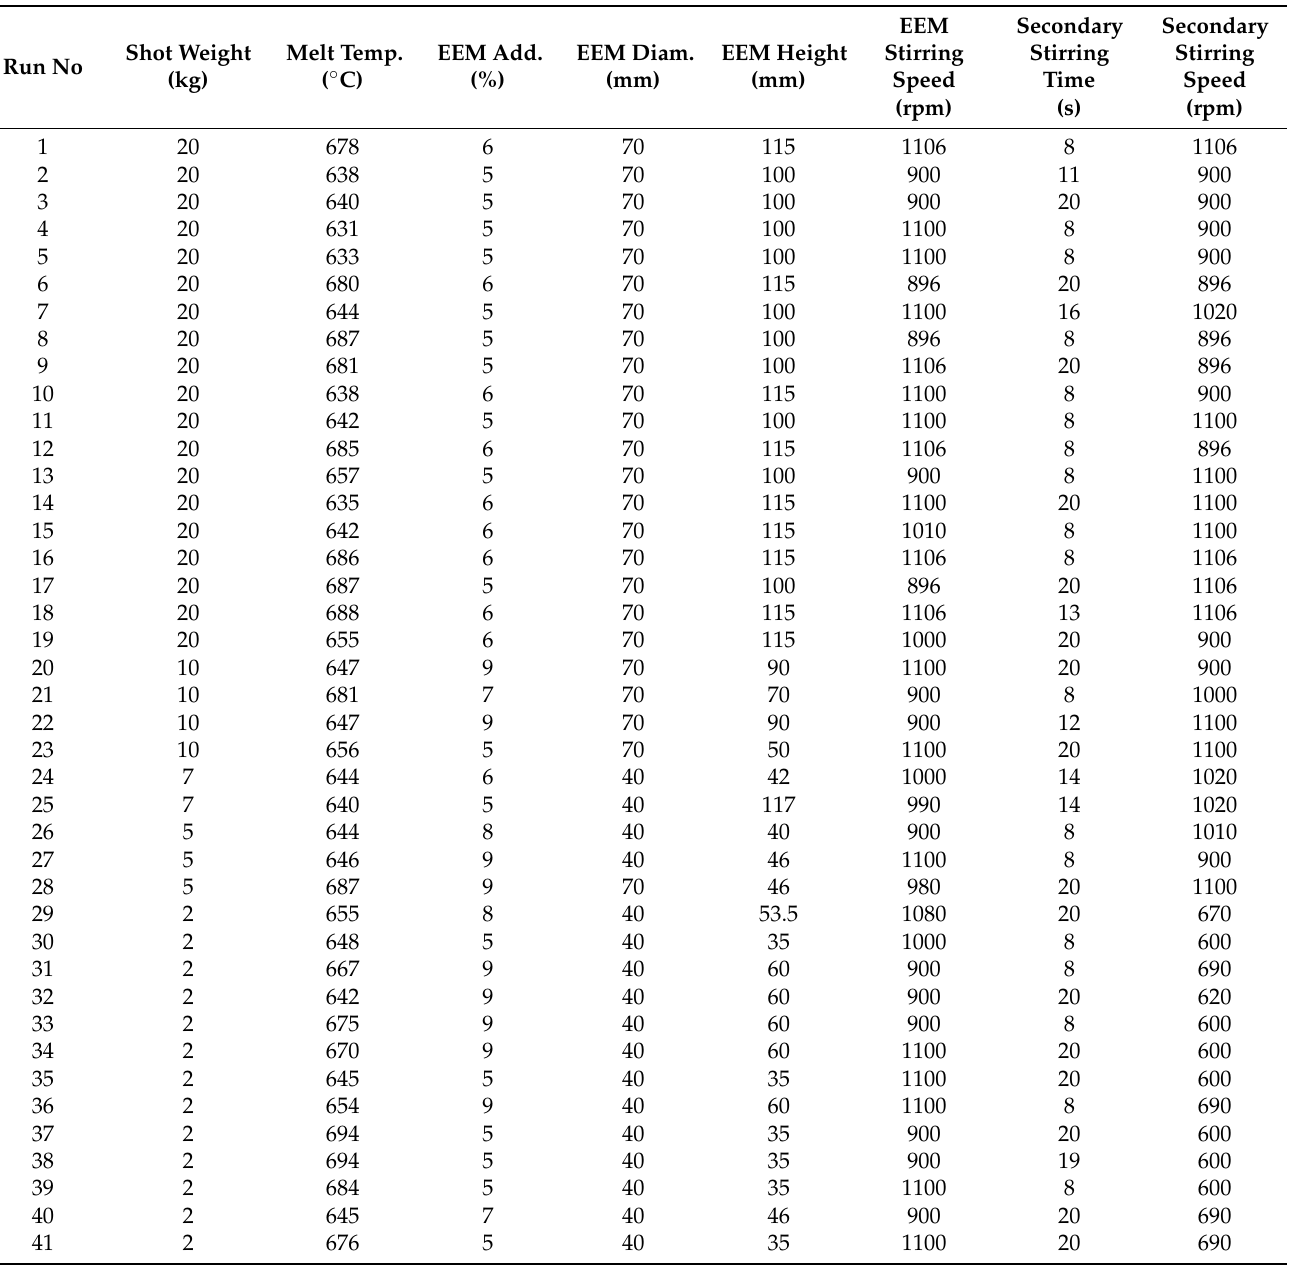
Table A1. Experimental planning based on statistical design of experiments using a D-Optimal